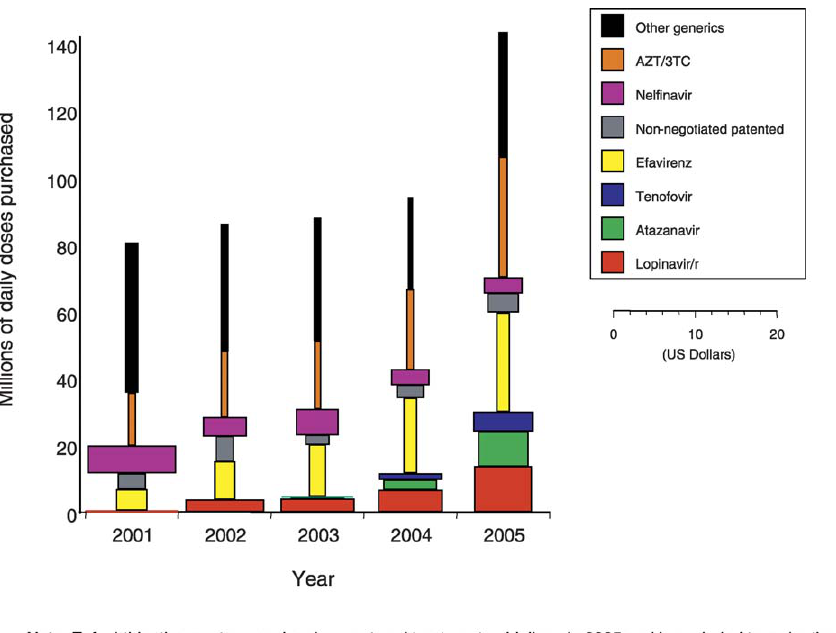
Figure 5. Contributions of Drug Price and Purchase Quantities to Total Cost, 2001–2005 The overall contribution of a particular drug to total costs in a given year is represented by the area of the rectangle that represents that drug. Changes in quantities for a particular drug appear as changes in the height of the rectangle. Changes in the price per daily dose of each ARV appear as changes in the width of the bars. The values associated with the width of the bars are reflected in the legend. The overall height of the bars in each year reflects the estimated total number of doses purchased in that